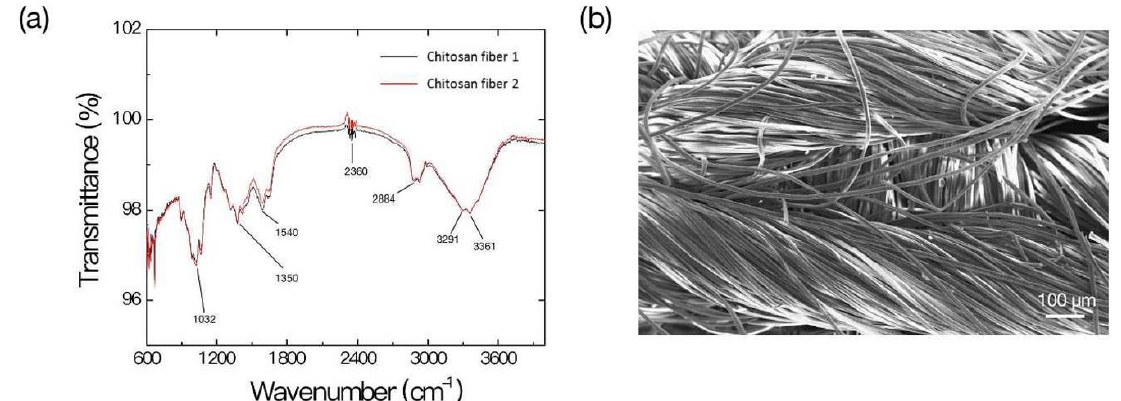
Figure 1. Characterization of the chitosan dressing. ( a ) Fourier-transform infrared spectroscopy results; ( b ) Scanning electron microscopy observation.